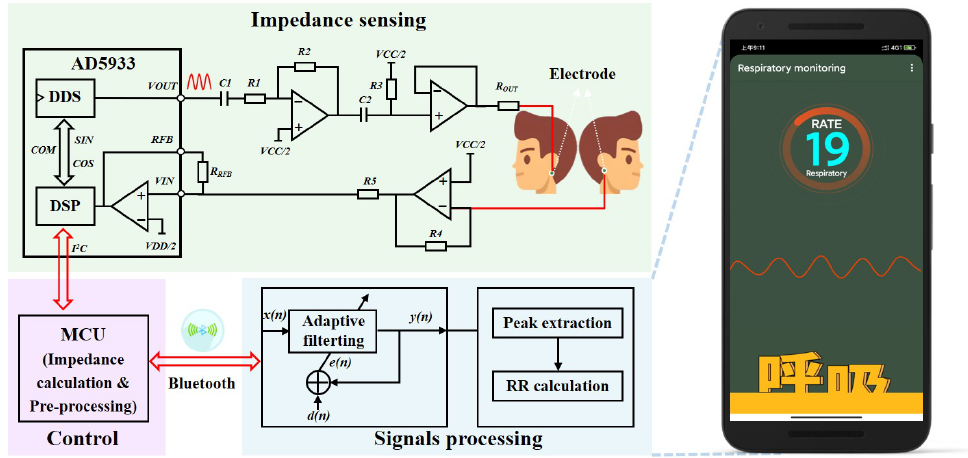
Figure 4. Schematic diagram of the electrical impedance sensing system for respiratory